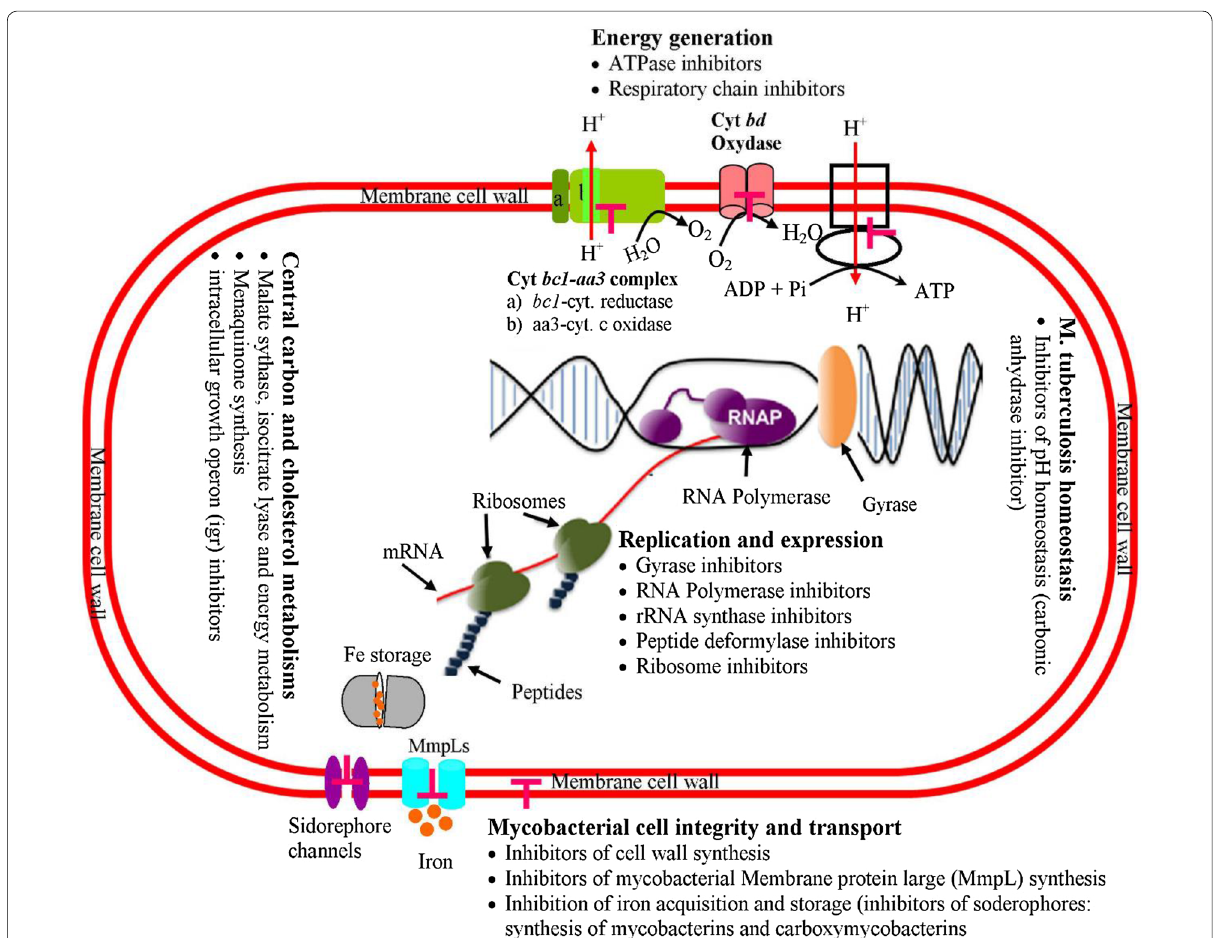
Fig. 2 Potential drug targets in M.tb metabolism. Various TB drugs exhibit different action mechanisms and target distinct metabolic levels of the M.tb cell that are indicated in Figure. Targets of inhibitor drugs are shown below each